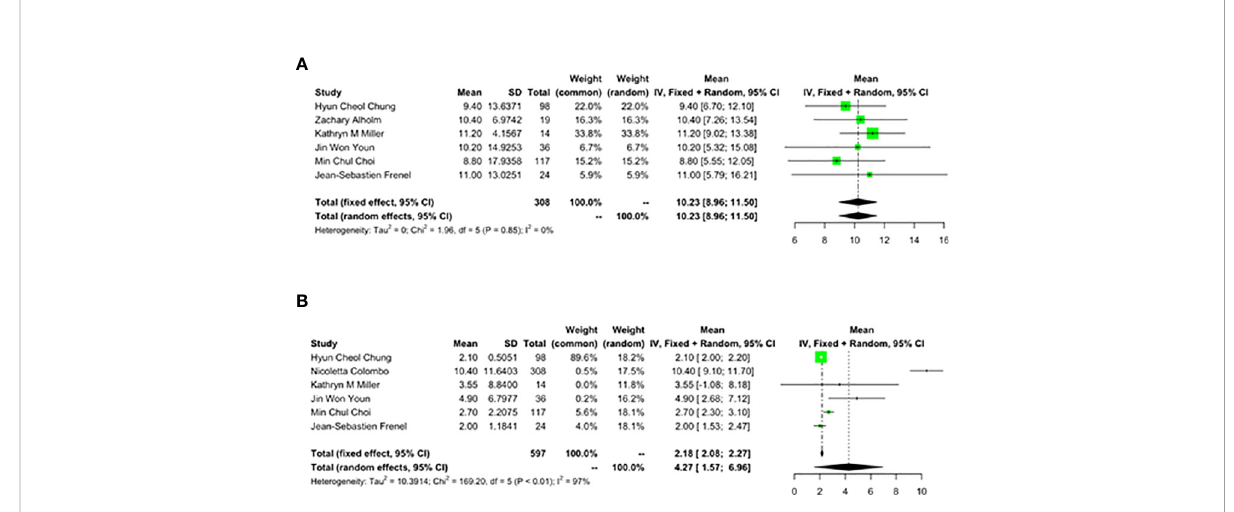
FIGURE 4 Overall survival (OS) and progression-free survival (PFS) for patients with cervical cancer receiving pembrolizumab therapy. (A) OS, (B)